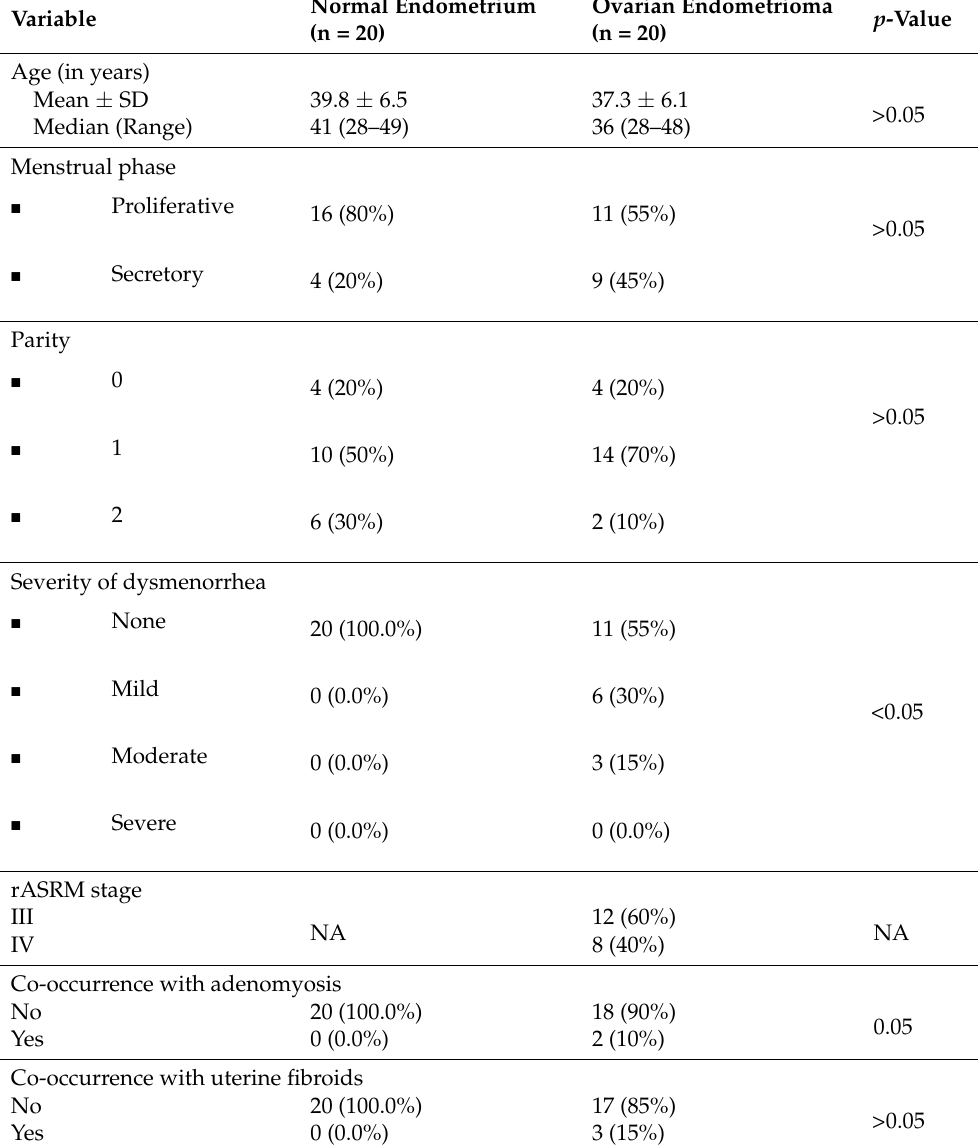
rASRM: Revised American Society for Reproductive Medicine classification system for